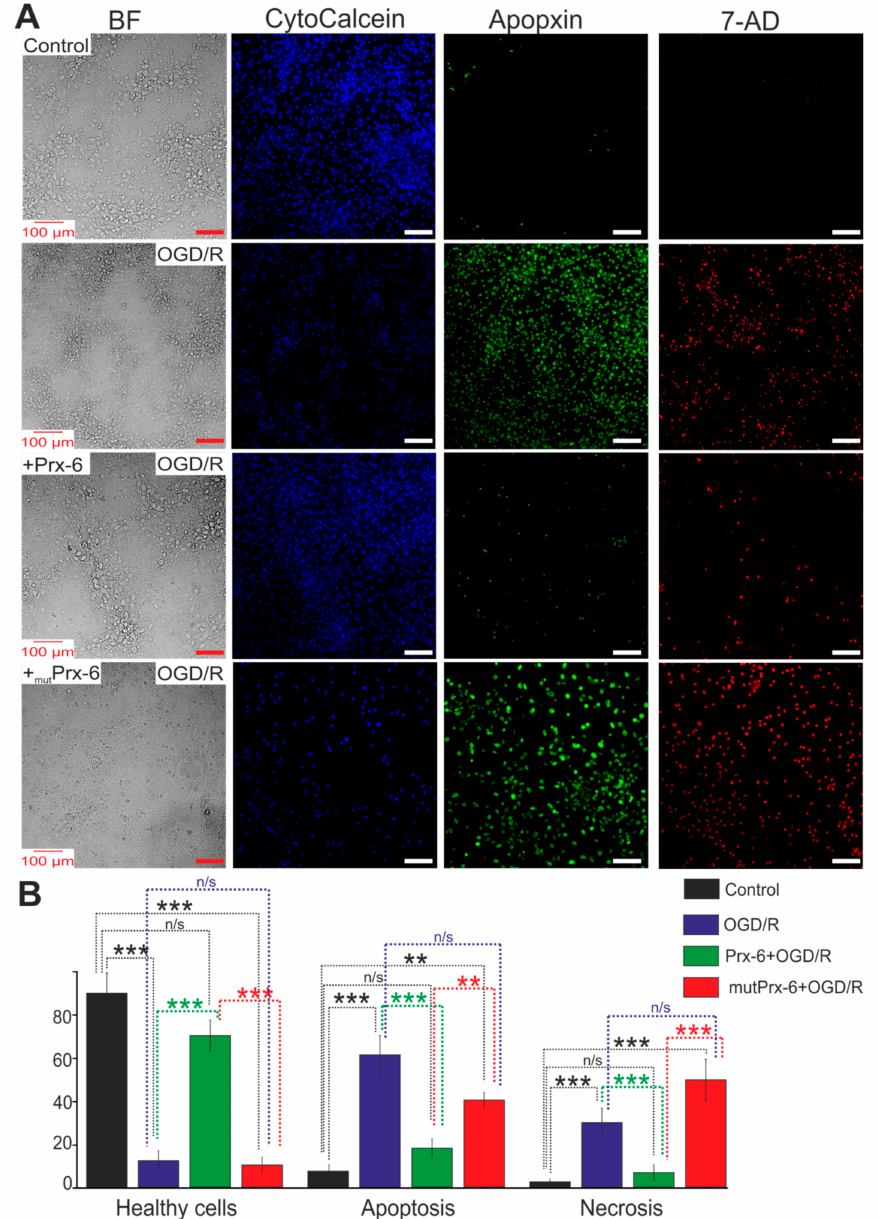
Figure 9. Effect of 24-h incubation of hippocampal cells with Prx-6 (100 µ M) and mutPrx-6 (100 µ M) on the OGD/R-induced apoptosis and necrosis. ( A ) Cell staining using the Apoptosis/Necrosis Detection Kit assay. BF—bright-field microscopy, CytoCalcein—living cells indicator, Apopxin— apoptotic cells indicator and 7-AD (7-aminoactinomycin D)—necrotic cells indicator. ( B ) Healthy cells and cells with apoptosis or necrosis after 40 min OGD and 24-h reoxygenation. Each value is the mean ± SE ( n ≥ 4). Statistical significance was assessed using paired t -test. n/s—data not significant ( p > 0.05), ** p < 0.01, and *** p < 0.001. Scale bar = 100 µ m. Thus, incubation of cells with Prx-6 leads to an increase in the expression of protective genes also after ischemia-reoxygenation, while mutPrx-6 without peroxidase activity, on the contrary, enhances the expression of genes encoding proteins involved in the activation of damaging signaling pathways. At the same time, after exposure with Prx-6, inflammatory factors were suppressed, which contributed to a decrease in the number of cells dying from necrosis and